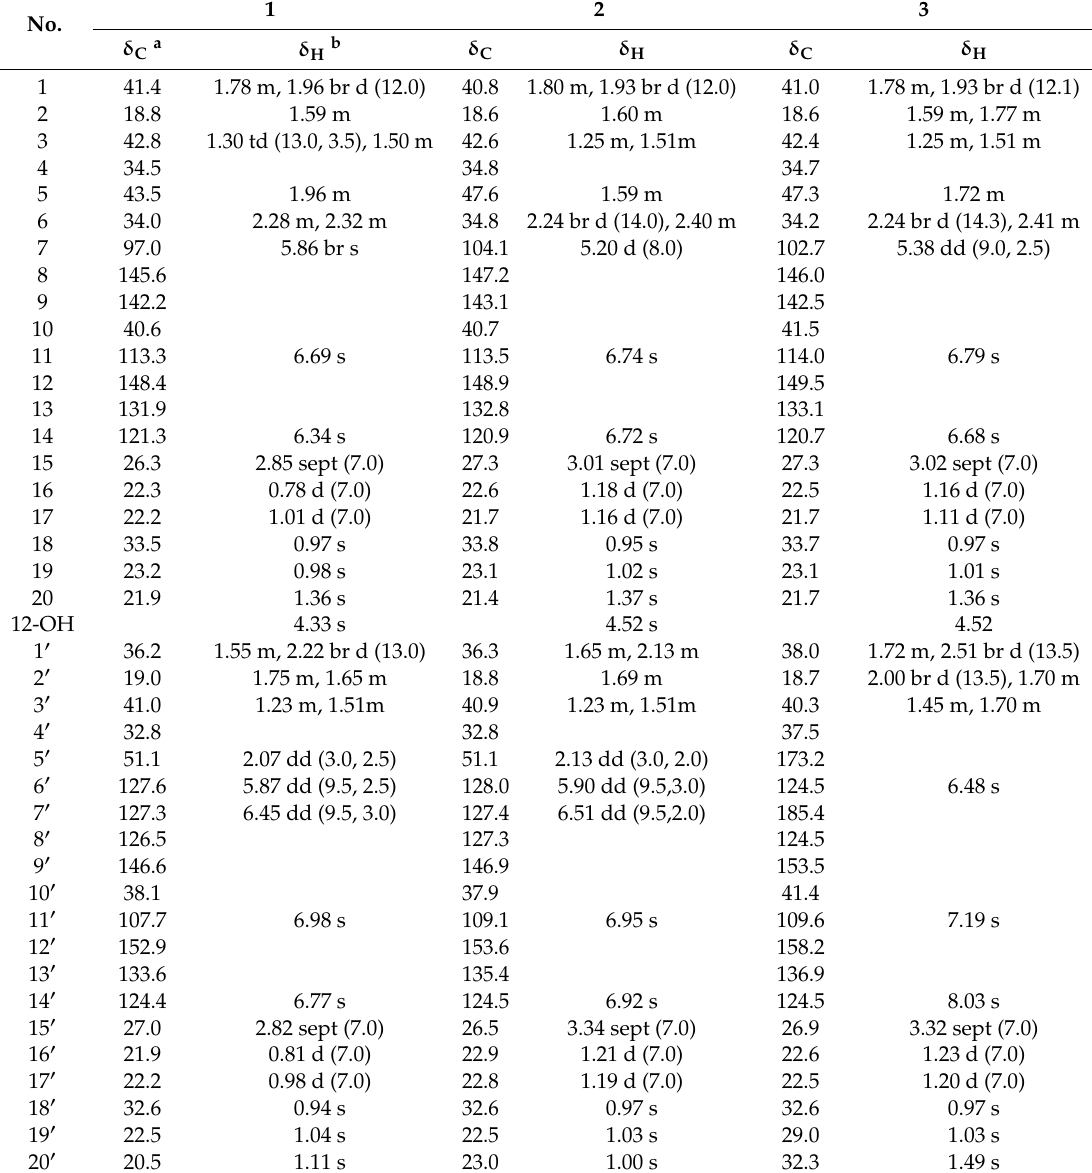
Table 1. NMR (nuclear magnetic resonance) data (CDCl 3 ) of compound 1 – 3 . δ in ppm, J in